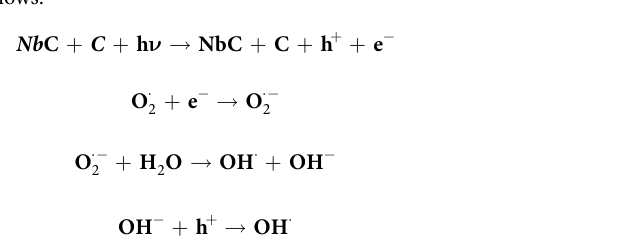
For all the samples, degradation efficiency is a function of phase content (NbC, NbC x O y , and Nb-O), π→π * transitions and oxygen vacancies present on the surface. Among all of these parameters, the presence of NbC x O y and π→π * governs whole catalytic reaction (as discussed in PL analysis). Moreover, oxygen vacancies promotes the delayed recombination (PL emission peak at 468 nm) which in turn provide more excitons 78 . But, excess